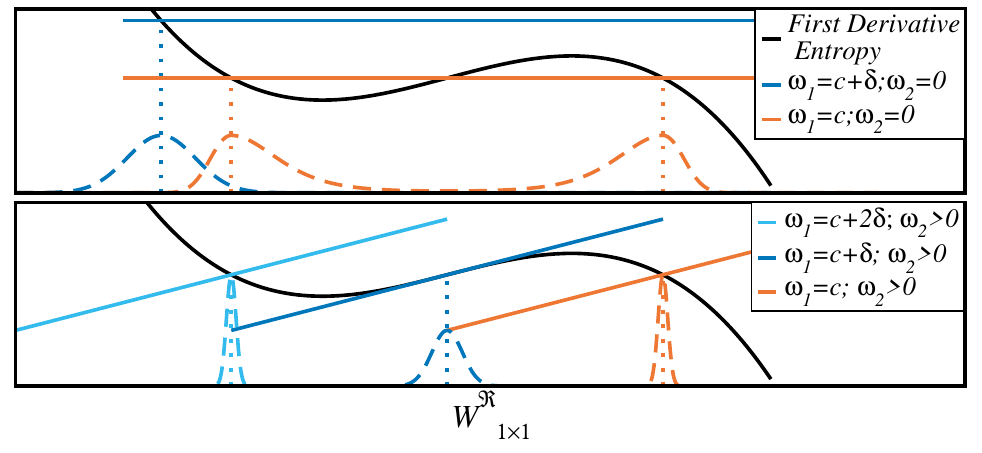
Figure 2 . Schematic representations of eq. (2.2), for distinct ensembles. The black lines represent the first derivative of the entropy near a first order phase transition. The straight blue ones show the contributions coming from the different ensembles. On the bottom of each plot, we sketch the histograms expected when performing Monte Carlo with these parameters. In the top , we present the canonical ensemble. Depending on the value of the ω 1 , we can have more than one solution, as seen in the lighter curve. A slight change in the parameter will transform one of the global maximum into a local maximum (of the probability). It is this local maximum that leads to hysteresis. On the bottom , we show the results for the ensemble proposed in eq. (2.2). For a large enough value of ω 2 , there will be only a solution, for all values of ω 1 , which removes hysteresis